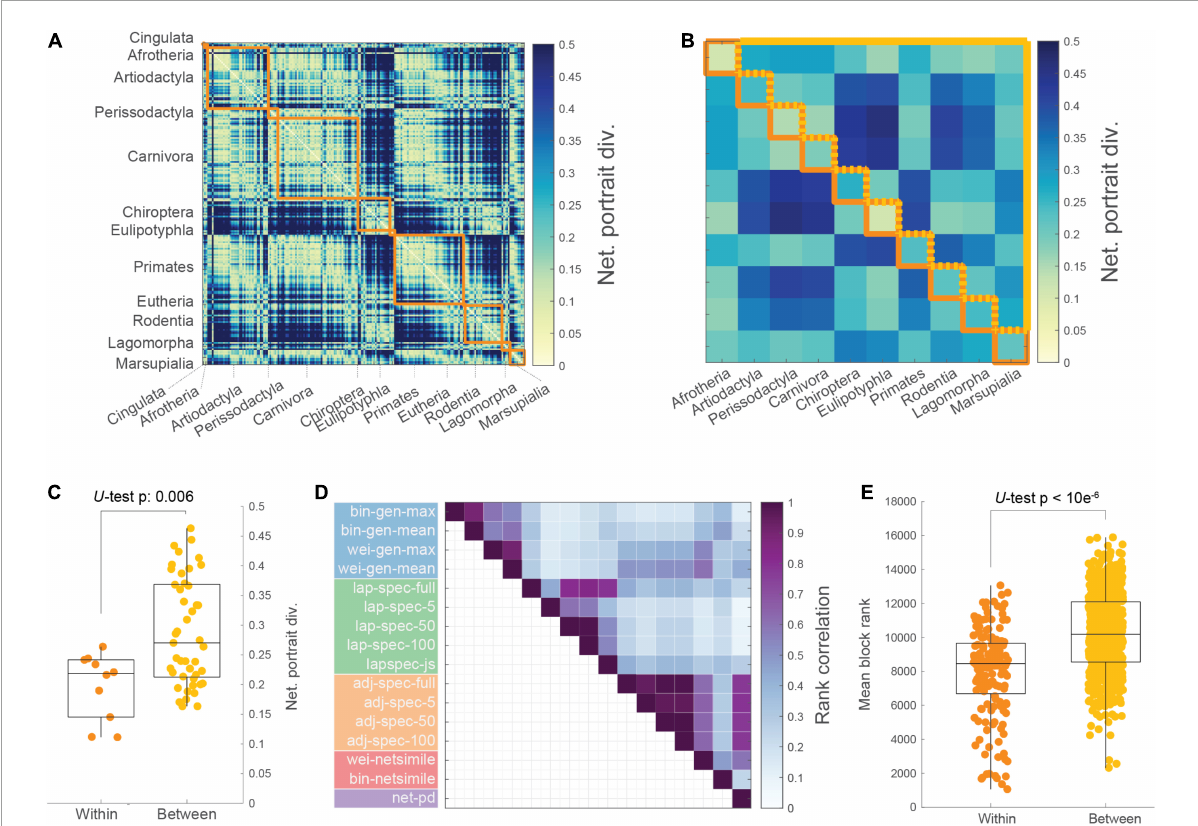
FIGURE2 Network distances correspond to taxonomic order. (A) Network portrait divergence matrix (with dimensions 201-by-201) for all mammals, organized by taxonomy into on-diagonal blocks (orange). (B) Average network portrait divergence within (orange) and between (yellow) taxonomic blocks. (C) Within-order average distance is lower than between-order average distance (Mann-Whitney U -test, p = 0.006). (D) Rank correlations between distance patterns produced by a variety of distance measures; bin: binary; wei: weighted; lap: Laplacian matrix; adj: adjacency matrix; gen: generative distance; spec: spectral distance; js: Jensen–Shannon divergence; netsimile: NetSimile distance; net-pd: network portrait divergence. (E) Aggregating all distance measures, the ranked within-order distance is lower than the ranked between-order distance ( U -test, p < 10 6